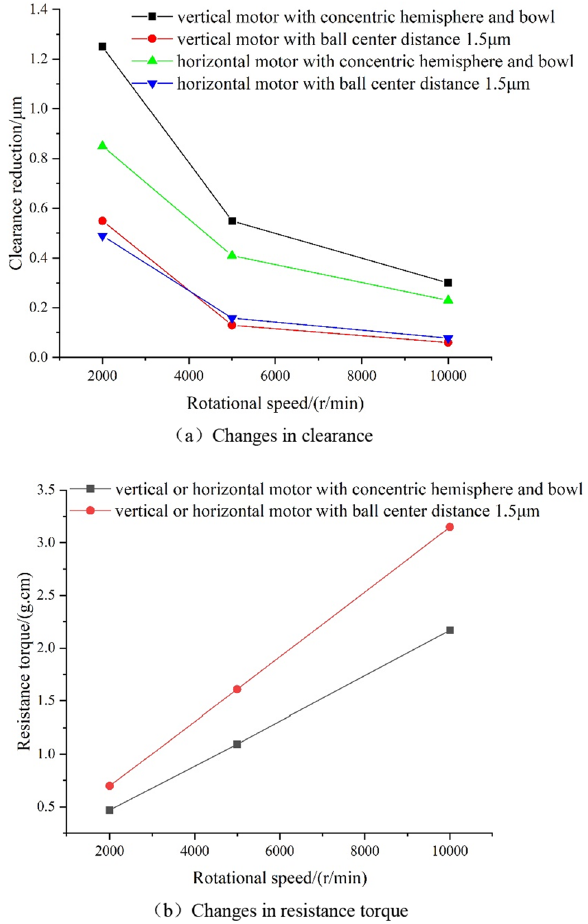
Figure 10. Changes of clearance and resistance torque during motor stopping.